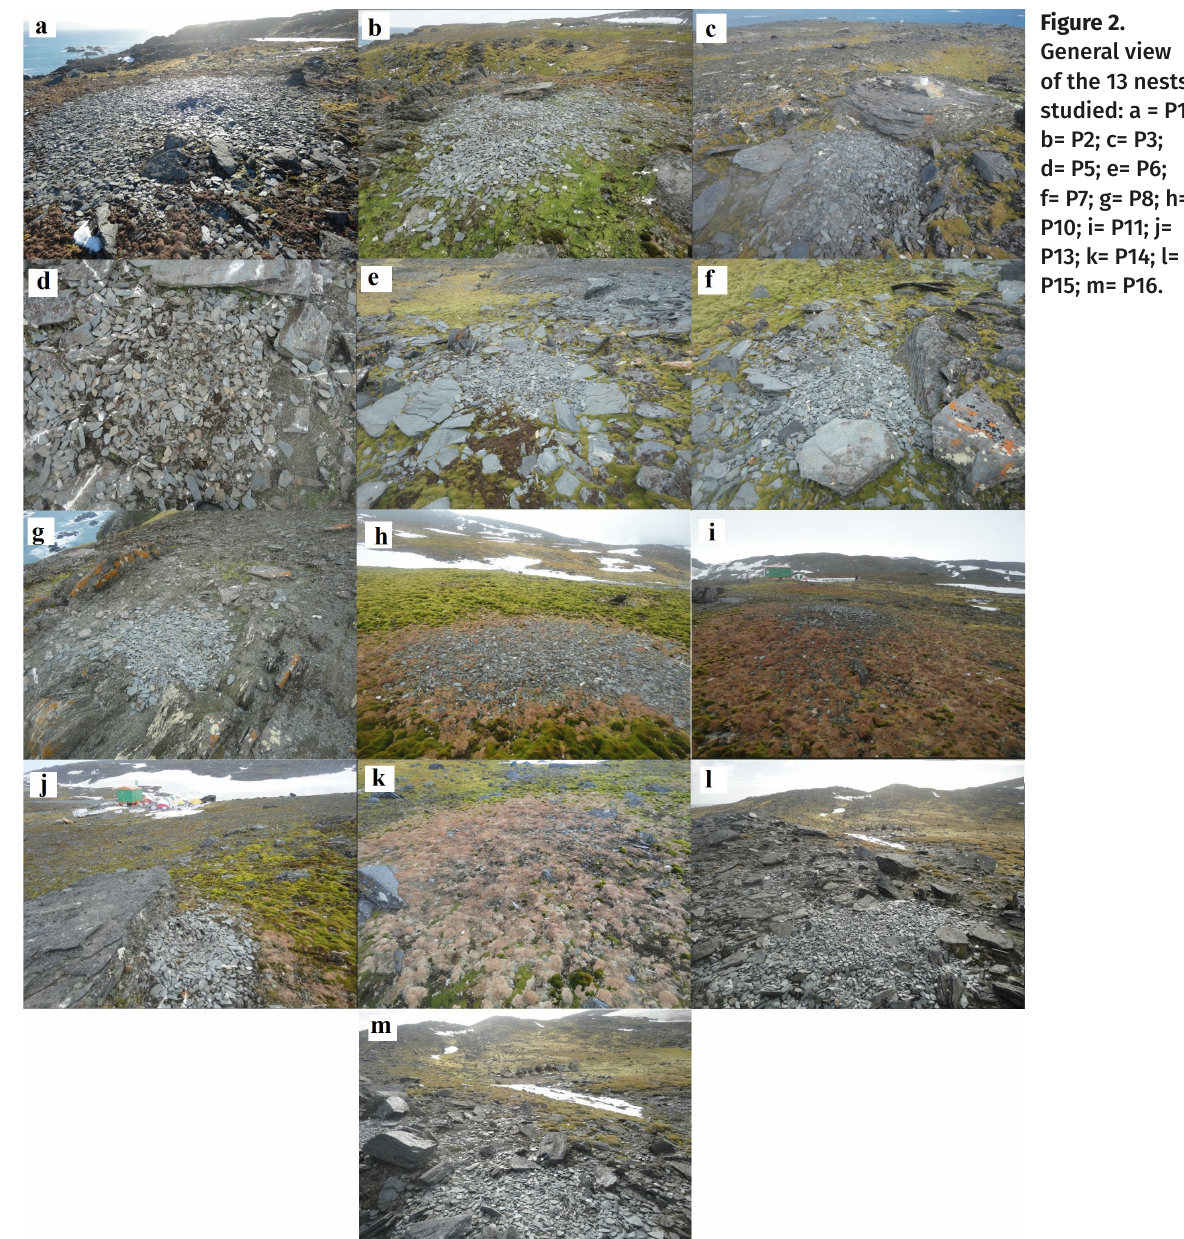
Figure 2. General